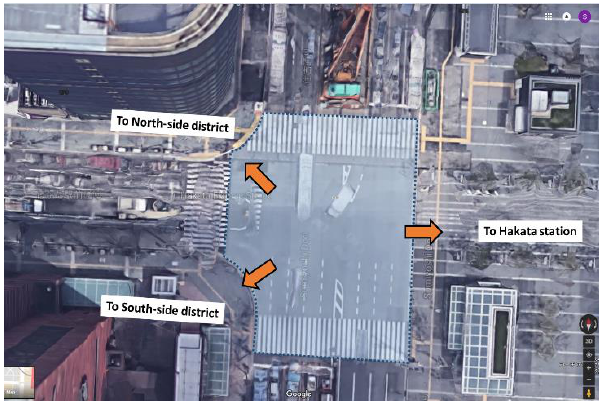
Figure 4. The 3-way intersection in front of Hakata station allows pedestrians to cross the street in different directions according to its signal at any given time.